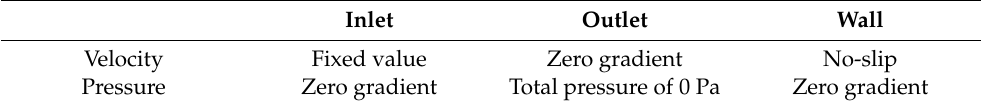
Table 1. The boundary conditions.